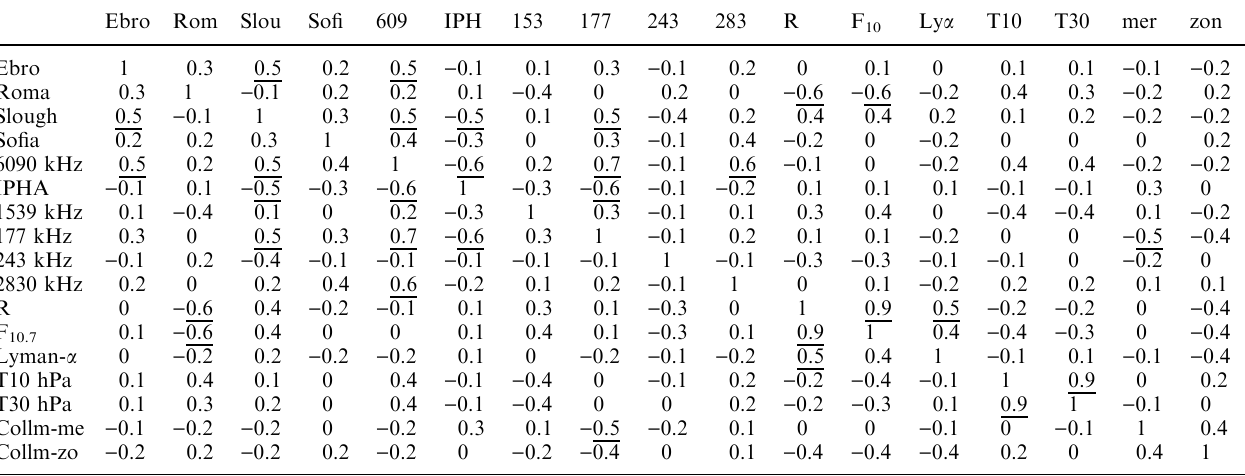
Table 6. Matrix of correlation coe(cid:129)cients for European iono- spheric parameters, solar parameters and meteorological para- meters, November 1994. Correlation coe(cid:129)cients significant at the 0.01 level are underlined. Negative correlations of